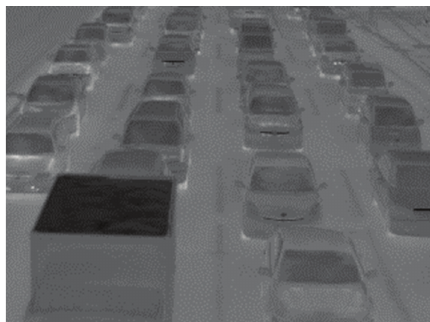
Figure 5: A thermal image in which the temperatures of the windshields and those of the exterior of the windshields are